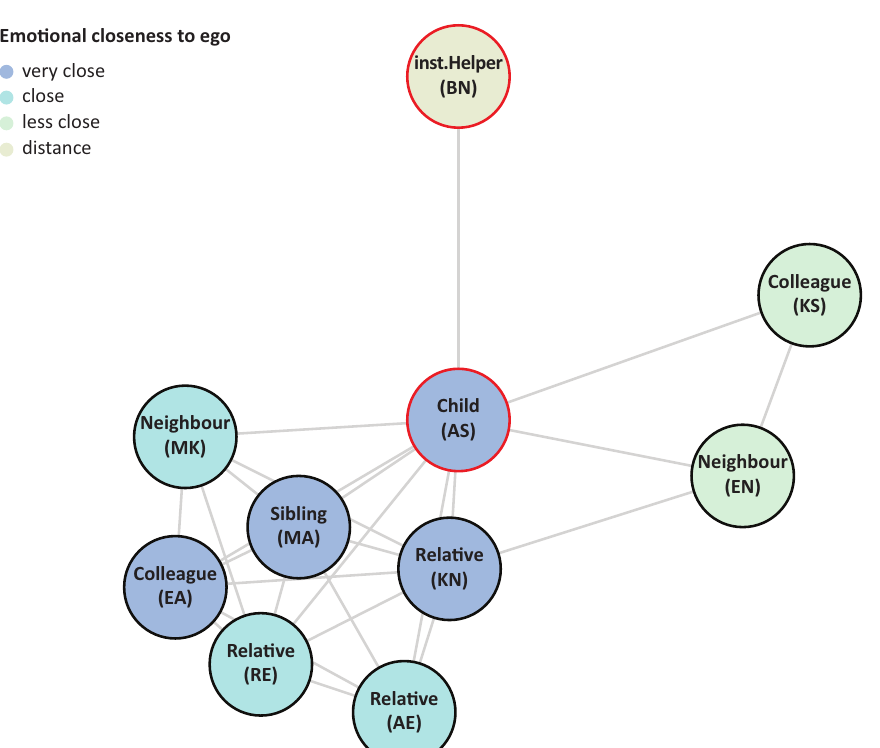
Figure 4. Ego‐centred network of Mrs Lindemann. Notes: Alters’ labels are derived from the relationship type reported by ego and a two‐letter anonymisation key; emotional closeness to ego indicated by node colour; conflictual relationships with ego indicated by red node frames; ties between alters indicate that they “know each other” according to ego’s account; layout based on the Fruchterman‐Reingold algorithm. Own